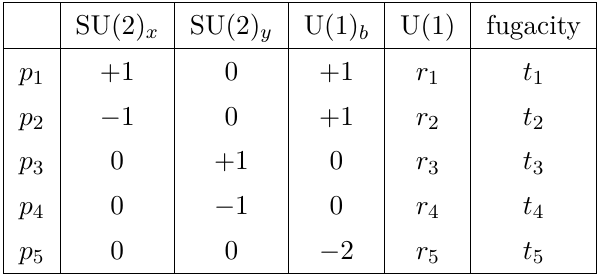
Table 15 . Global symmetry charges on the extremal brick matchings p i of Model